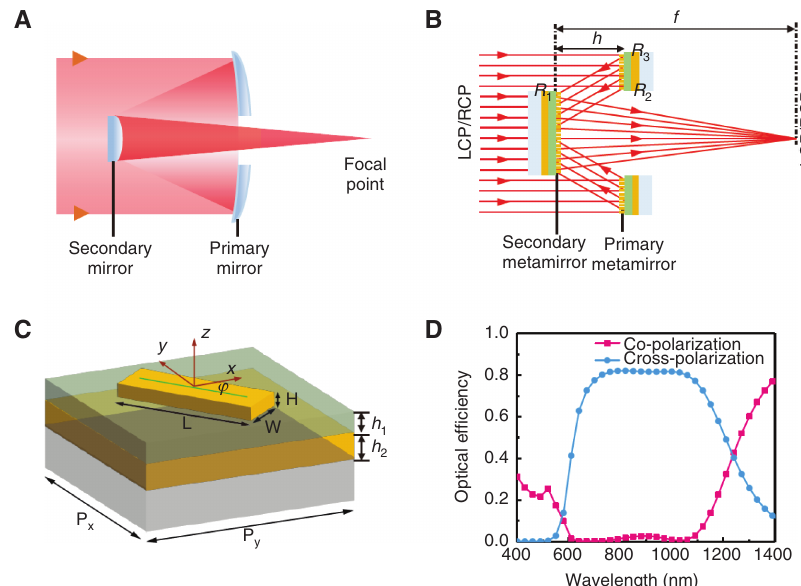
Figure 1: Schematic illustration of Cassegrain metasurface telescope and the design of meta-atom. (A) The conventional Cassegrain telescope made of a concave primary mirror and a convex secondary mirror. (B) The Cassegrain metasurface telescope. Conventional curved mirrors are replaced by planar metamirrors based on geometric P-B phase. The incident circularly polarized light is reflected twice with the metamirros and then focused with the same circular polarization state as incident light. (C) The geometric = 00 nm) and a SiO = 87 nm) layer; the configuration of the meta-atom for the metamirrors: glass substrate is coved by a gold layer ( h ( h 2 2 1 gold nanorod on top of the SiO layer with length L = 200 nm, width W = 85 nm, and height H = 30 nm; ϕ is the orientation angle of the gold 2 = P = 300 nm. (D) The numerically calculated cross-polarization nanorods in the x-y plane. The periods along the x and y directions are P x y and co-polarization polarization conversion efficiency for circularly polarized incident light upon reflections by the meta-atoms